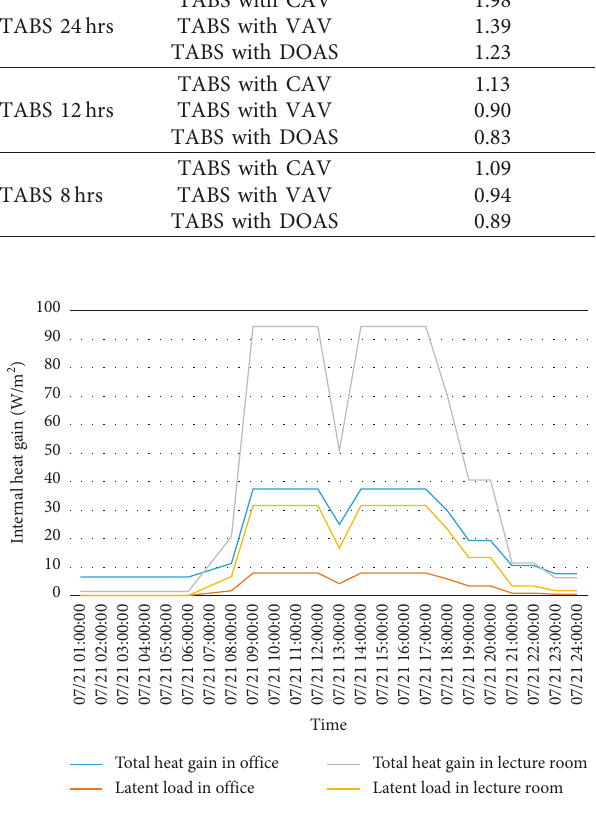
Figure 13: Internal heat gain of office and lecture rooms.